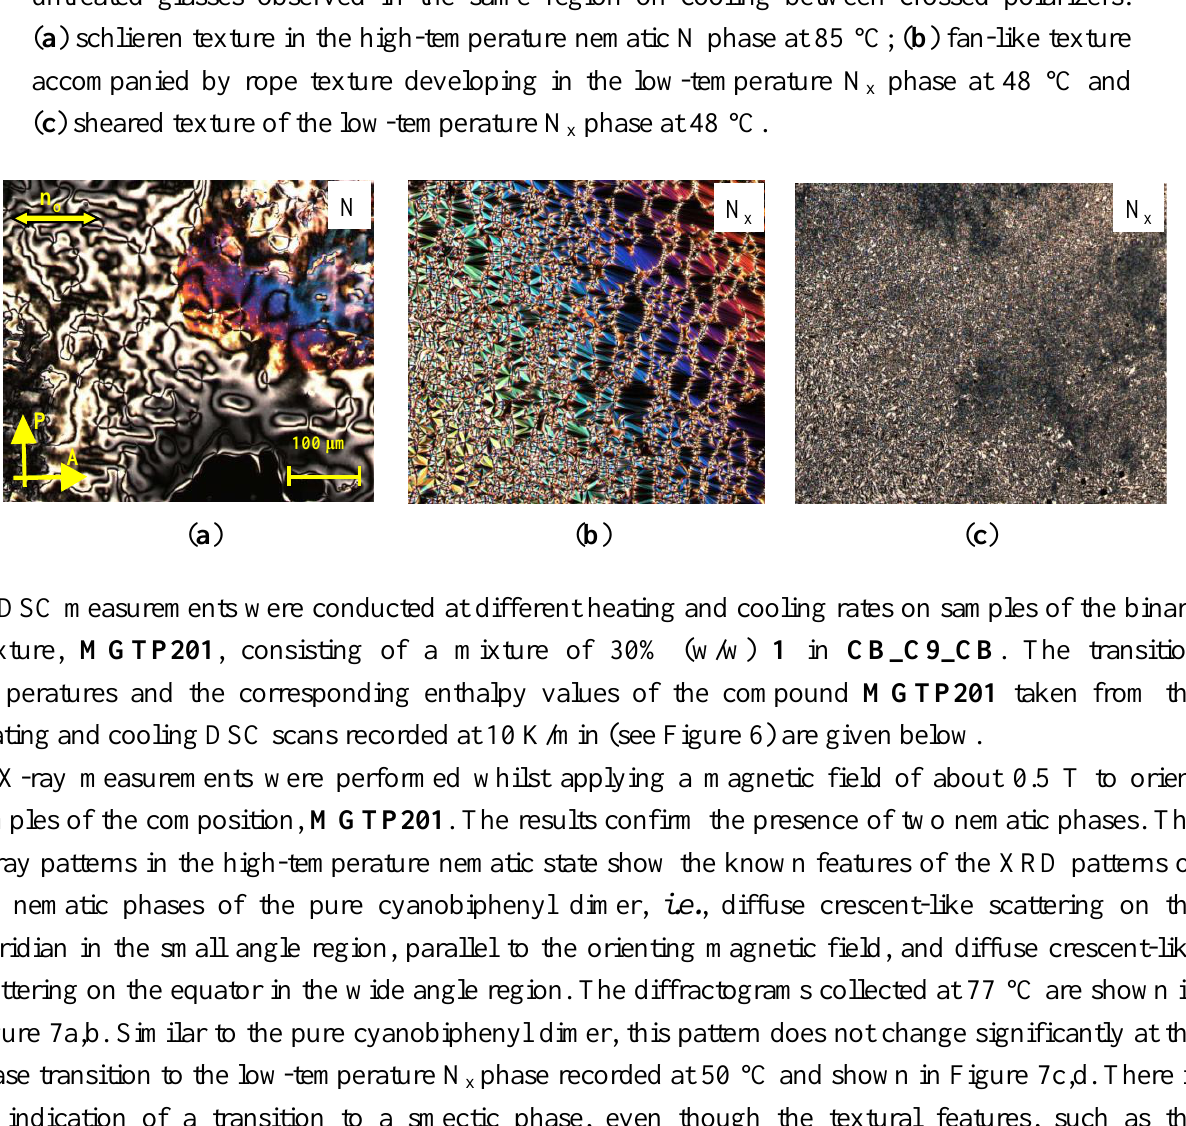
Figure 5. Textures of the MGTP201 (30% (w/w) 1 in 70% CB_C9_CB ) between untreated glasses observed in the same region on cooling between crossed